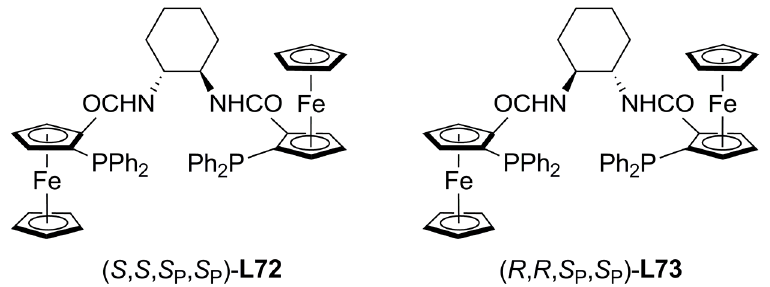
Figure 27. Ferrocenylphosphines analogous to TSL.